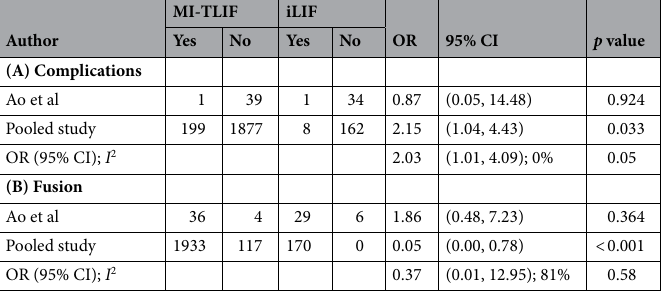
Table 9. Comparison of prevalence of complications and fusion between MI-TLIF and